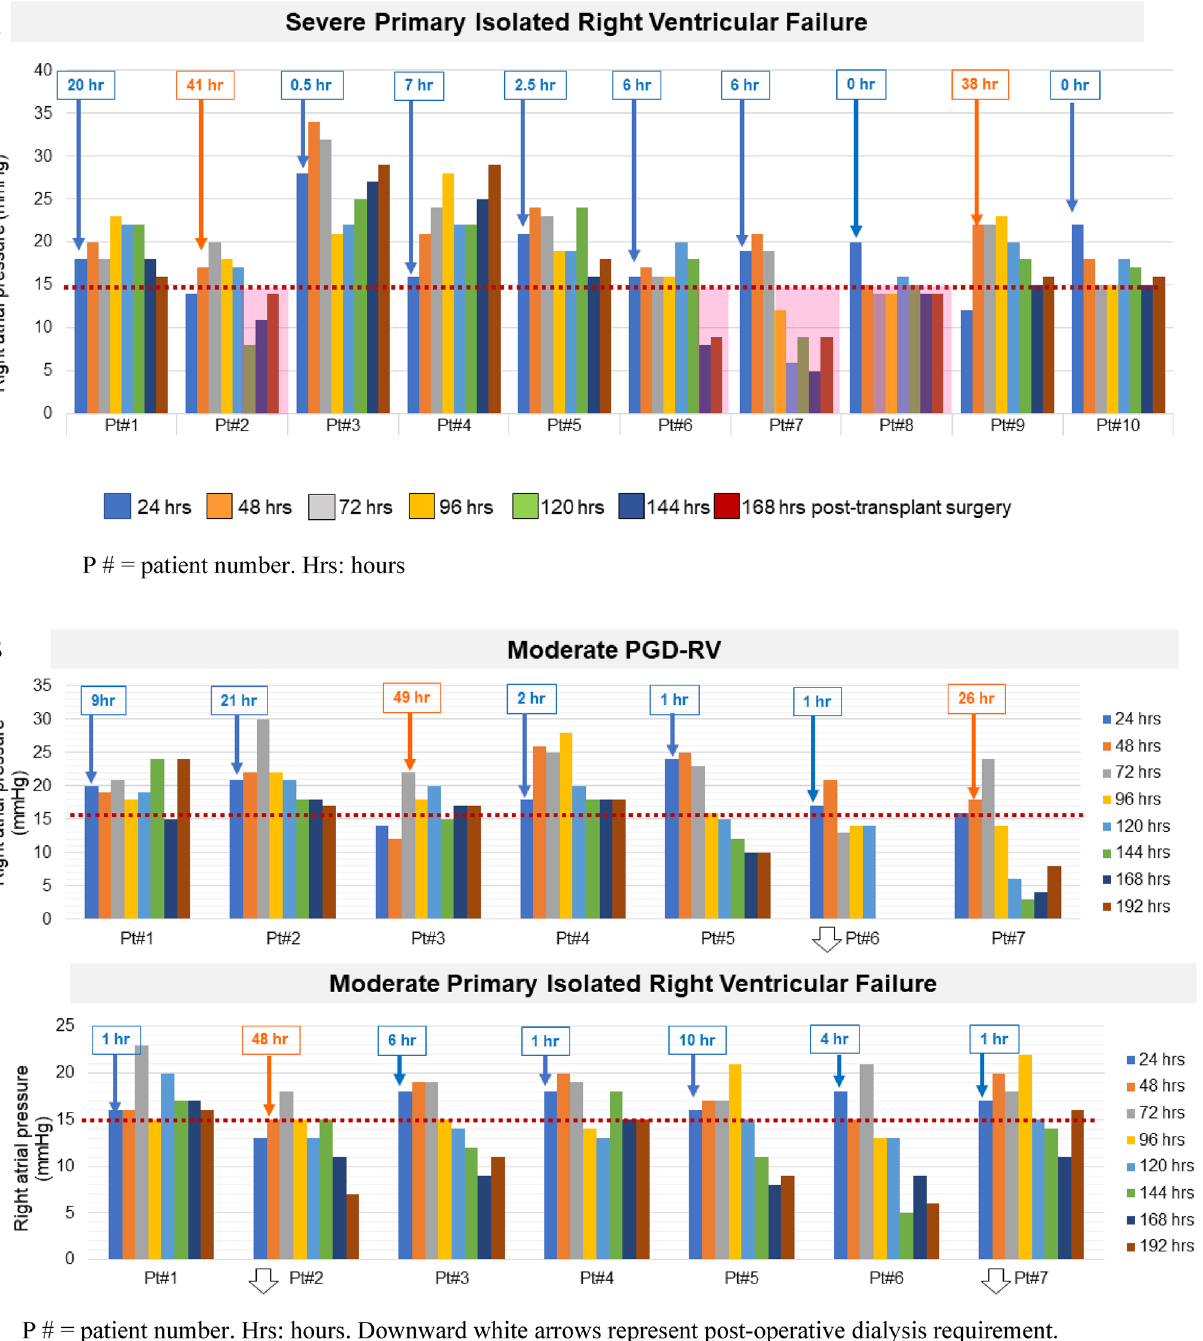
Figure 2. ( A ) Distribution of post-operative mean right atrial pressures in patients with severe right ventricular failure. ( B ) Distribution of post-operative mean right atrial pressures in patients with moderate right ventricular